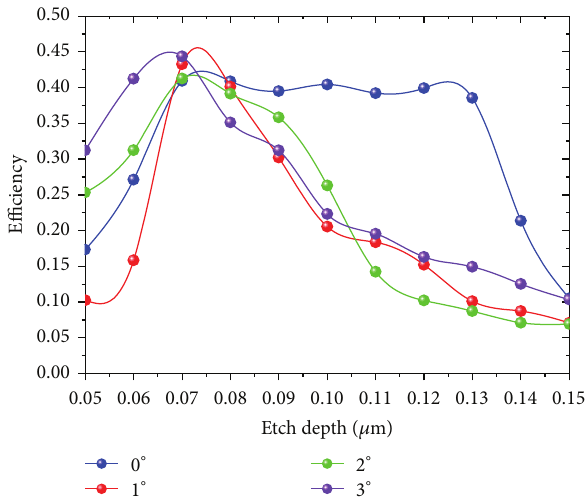
Figure 10: Coupling efficiency at different etch depths and incident